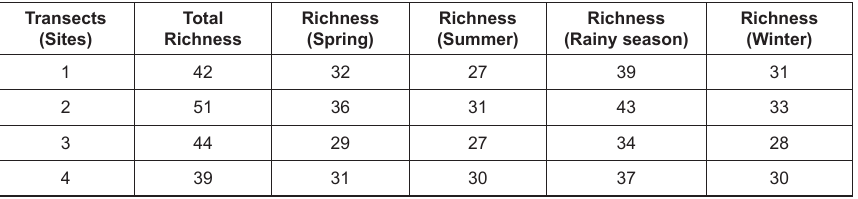
Table 3. Bird species richness for study sites in Dalma Wildlife Sanctuary, Jharkhand, India